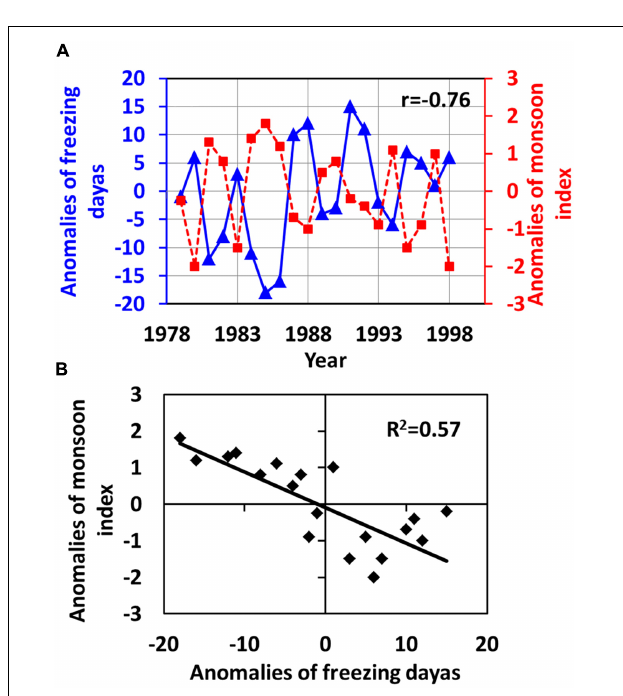
FIGURE 4 | (A) Changes in the anomalies of soil freezing days (blue solid line) and South China Sea summer monsoon index (red dashed line). (B) Correlation between the anomalies of soil freezing days and the anomalies of South China Sea summer monsoon index (Shang and Wang,